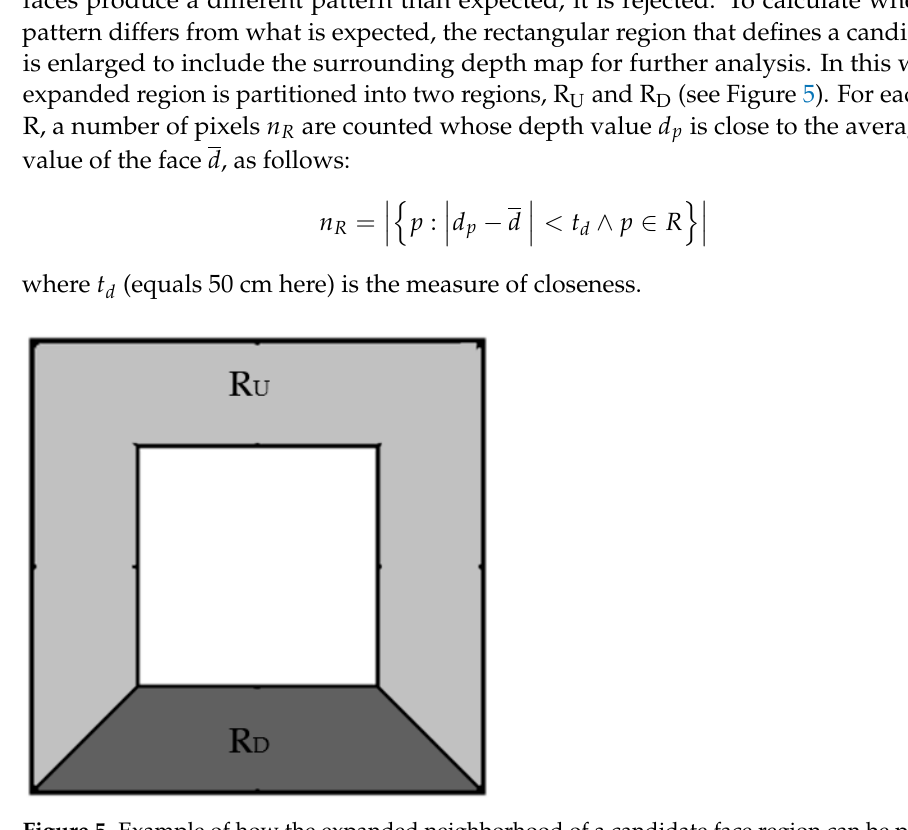
Figure 5. Example of how the expanded neighborhood of a candidate face region can be partitioned into two regions R U and R D. Region R D, depicted in dark gray, should contain the body.